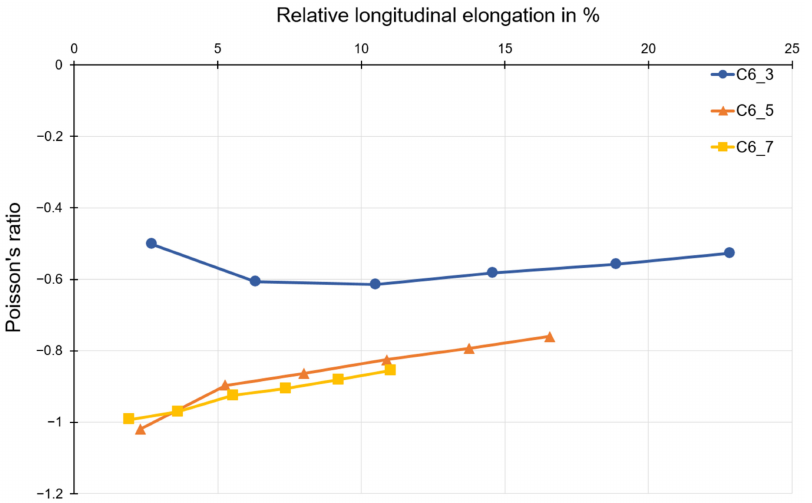
Figure 12. Poisson’s ratio as a function of relative longitudinal elongation for tested specimens made of polymer